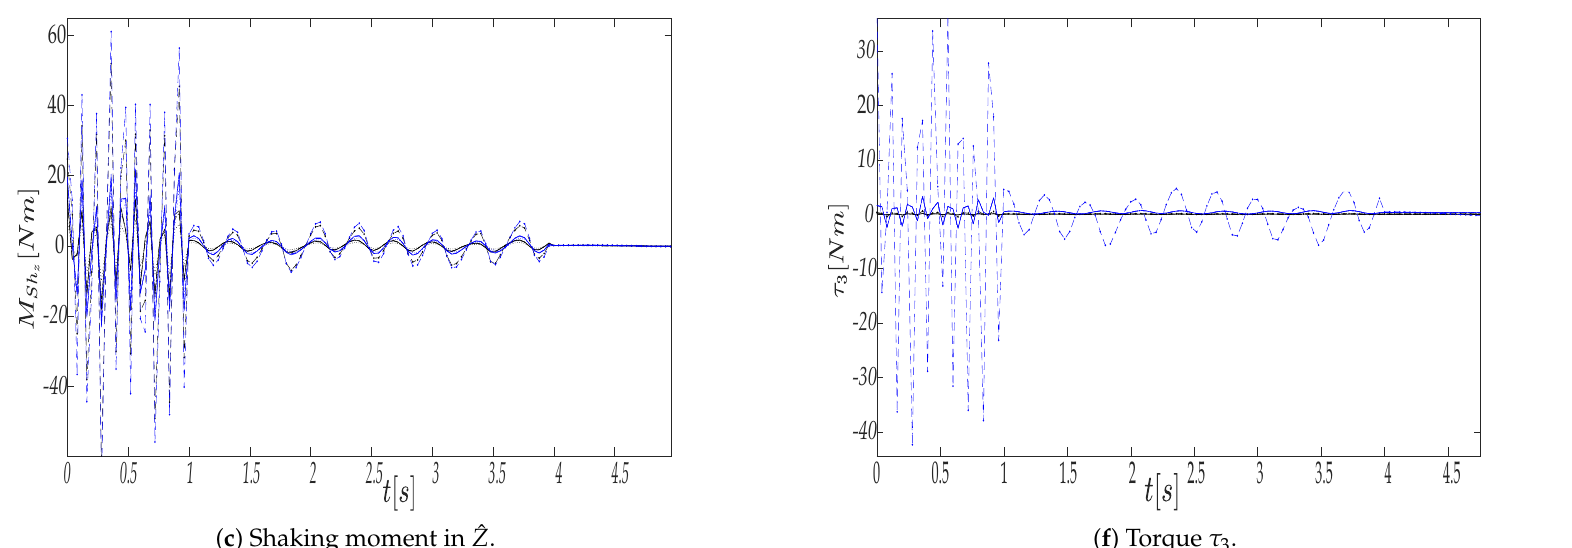
( c ) Shaking moment in ˆ Z . Figure 12. Behavior of the shaking force F Sh , shaking moment M Sh , and torque τ for the designs with different velocities and two different end-effector masses in z the hypocycloid trajectory. The design behaviors associated with m e = 0 kg are described in lines as RBD, − · − · − DBD, − − −− DTBD, · · · · ·· SMBD, − · − · − SFBD. The design behaviors associated with m e = 0.5 kg are described in lines as RBD, − · − · − DBD, − − −− DTBD, · · · · ·· SMBD, − · − · −